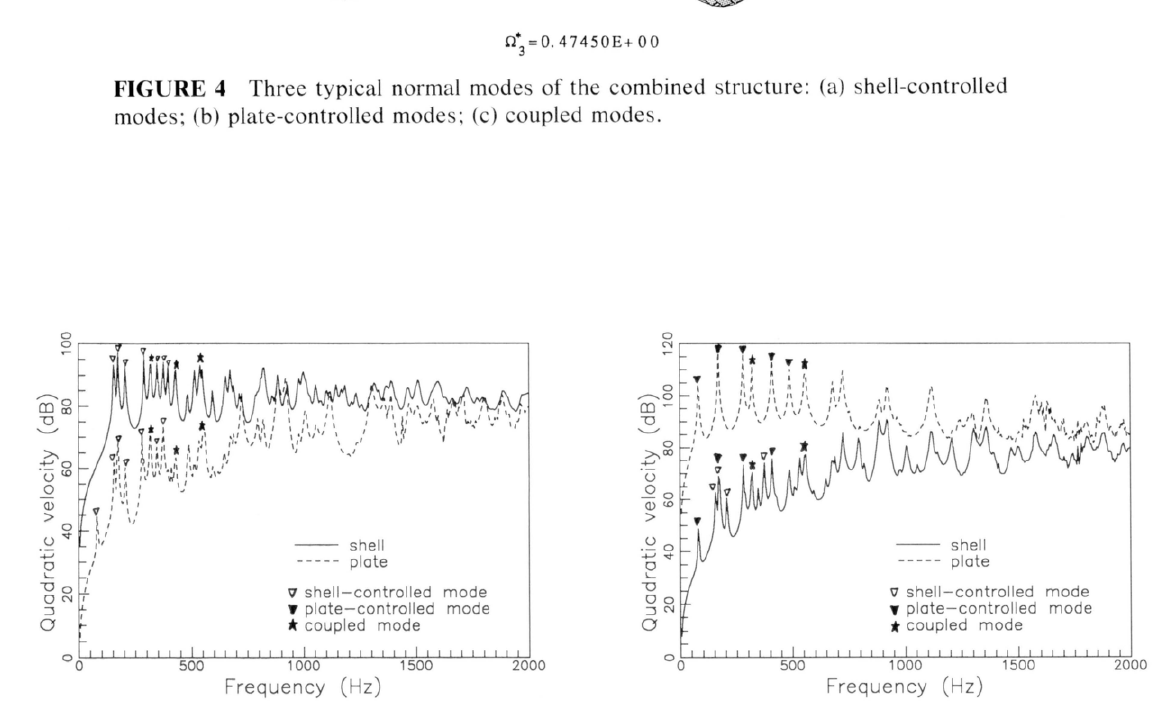
FIGURE 5 Quadratic velocity of the structure with the shell subjected to a unit point load.